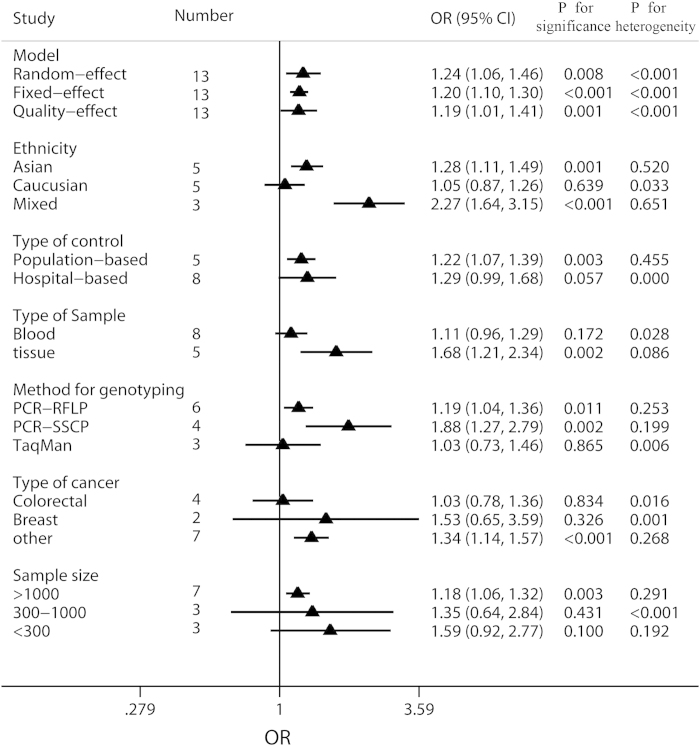
Meta-analysis of the association between Int7G24A polymorphism and cancer
risk applying dominant model.The triangles and horizontal lines correspond to the subgroup-specific ORs
and 95% CIs. The vertical solid line shows the OR of 1. Especially,
“Other” indicates other kind of cancer in addition
to breast cancer and colorectal cancer, including 2 ALL studies (T-lineage
and B-lineage), 1 cervix cancer study, 1 NSCLC study, 1 osteosarcoma study,
1 RCC study, 1 TCC study, 1 ESCC study, 1 colon adenoma study, and 1 GCA
study; “Mixed” means mixed population with Caucasian
and African-American.